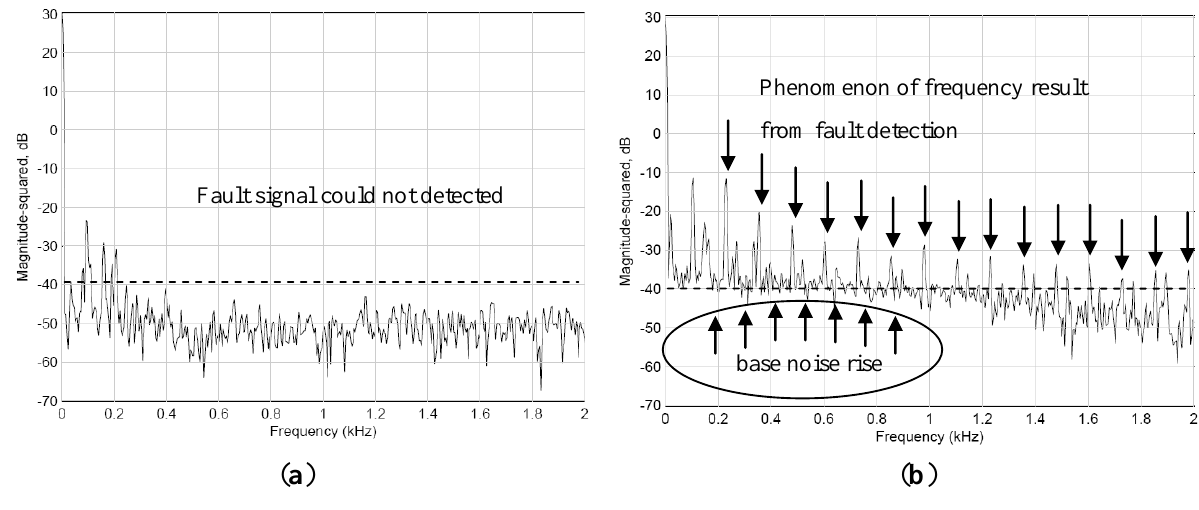
Figure 8. ( a ) The spectrum obtained using traditional methods, where no vibrations caused by faults were detected. ( b ) The multiplied vibration frequencies obtained using the WPMS when faults